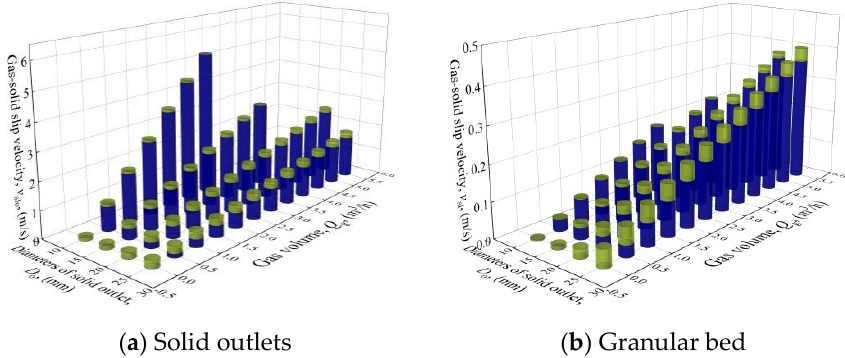
Figure 10. Gas–solid slip velocity under different conditions.